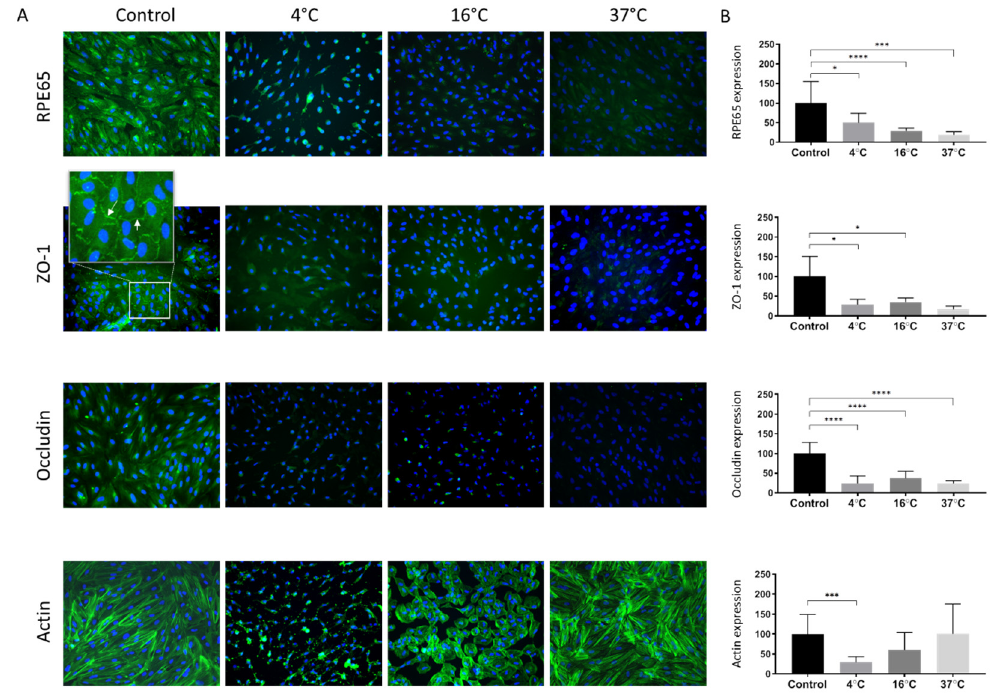
Figure 4. The effect of storage temperature on ARPE-19 cell phenotype. ( A ) The expression of RPE65, ZO-1 (white arrow points within a zoomed inset), occludin and actin in ARPE-19 cell cultures stored for three weeks at 4 °C, 16 °C, or 37 °C was compared with non-stored control cultures. Nuclear DNA was stained with 4 ′ ,6-diamidino-2-phenylindole (blue). ( B ) Expression of the markers quantified by measuring the total fluorescence intensity normalized by cell number. The bar charts show the fluorescence intensity of anti-RPE65, anti-ZO-1, anti-occludin, and anti-actin relative to control cultures (100%). Magnification 200×. Data are expressed as mean ± standard deviation of the mean. * p < 0.05, *** p < 0.001 and **** p < 0.0001